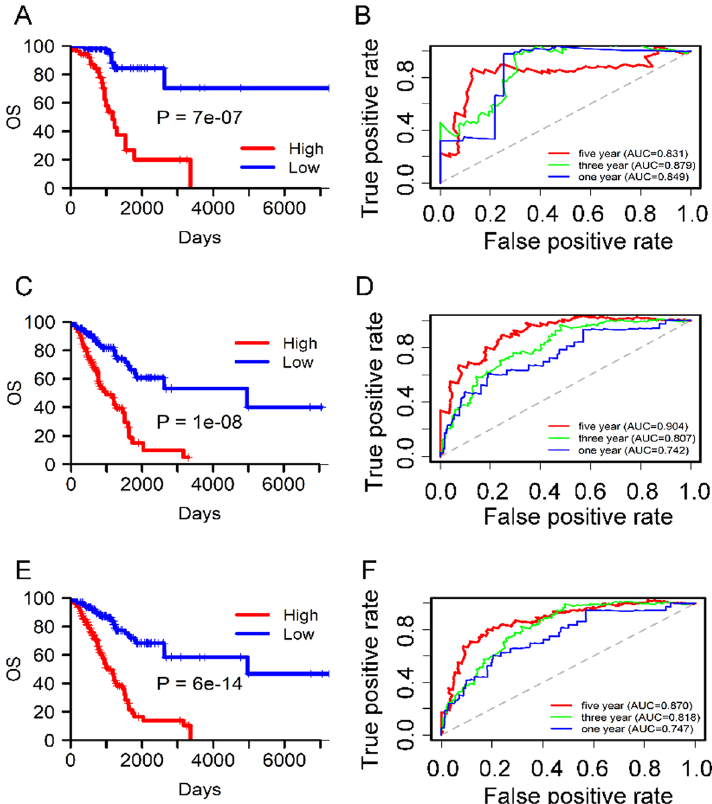
Figure 4. Kaplan–Meier and ROC analysis of patients with stage I–II LUAD in in training, validation and whole datasets. ( A , C , E ) Kaplan–Meier analysis for stage I–II LUAD patients between the low-risk and high- risk. The x-axis is follow-up time, the y-axis is OS. The log-rank test indicated the higher risk scores were significantly correlated with worse OS (P < 0.05). ( B , D , F) 1-, 3-, 5-year ROC curves of the 11-DNA methylation signature. Blue line, green line and red line represent 1-, 3-, 5-year ROC curves